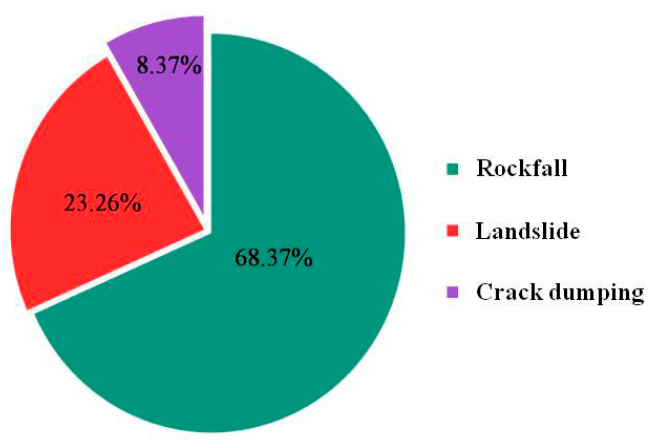
Figure 8. Proportion of geological hazards in red-bed slopes in South China.